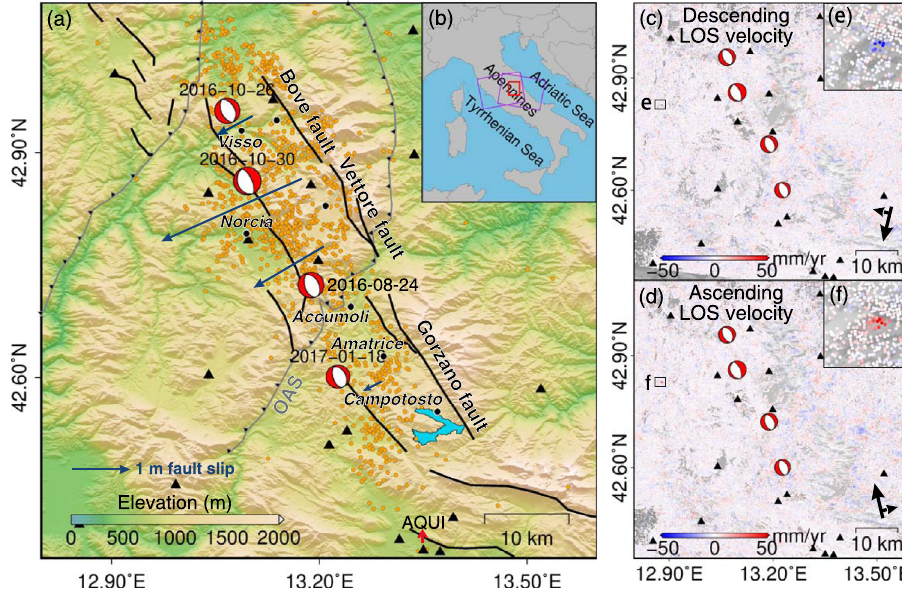
Fig. 1 | Seismotectonic background of the study area and velocity fi elds along theradarLine ofSight(LOS) directionderivedfromInterferometric Synthetic Aperture Radar (InSAR). a Seismotectonic background with the four 2016 – 2017 earthquakes. Solid black lines represent the major active faults while gray barbed lines indicate the pre-existing compressional faults 22 . The locations and moment tensor solutions of the four main earthquakes in Central Italy from 2016 to 2017 (red beach balls) were obtained from the United States Geological Survey (USGS). Dark blue arrows indicate the maximum fault slips of the four events 22,74 . Orange